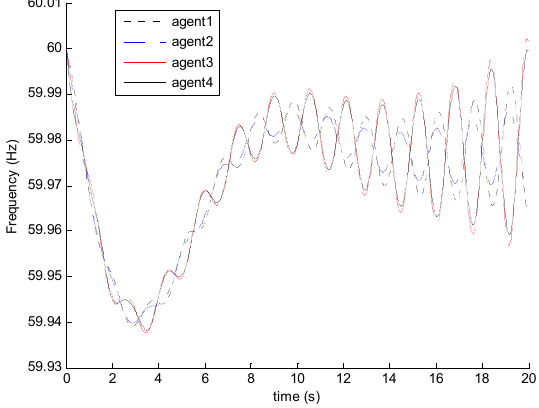
Figure 2. The frequency deviations without control in a small disturbance.